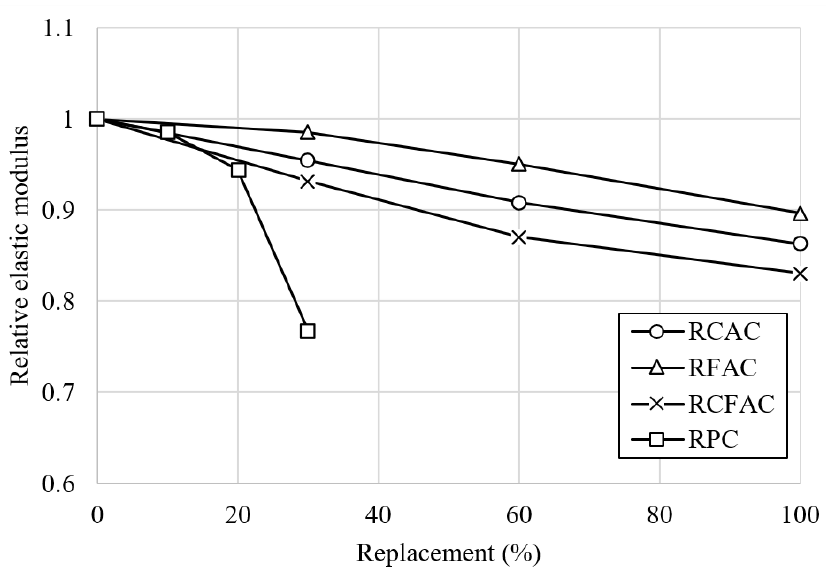
Figure 9. Relative elastic modulus of various concretes by replacement ratio.